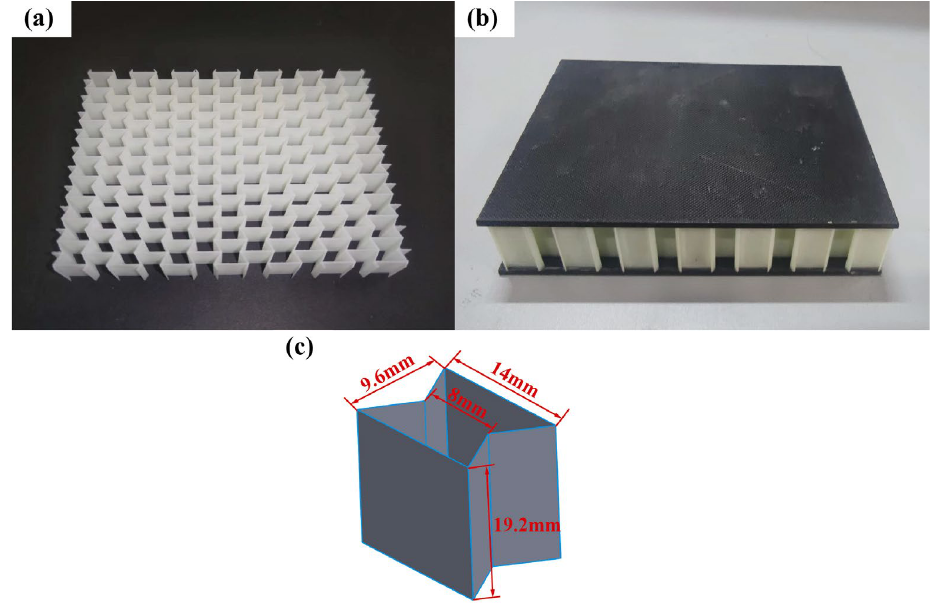
Figure 8. Traditional re-entrant honeycomb sandwich panel. ( a ) core; ( b ) specimen; ( c ) a unit cell.